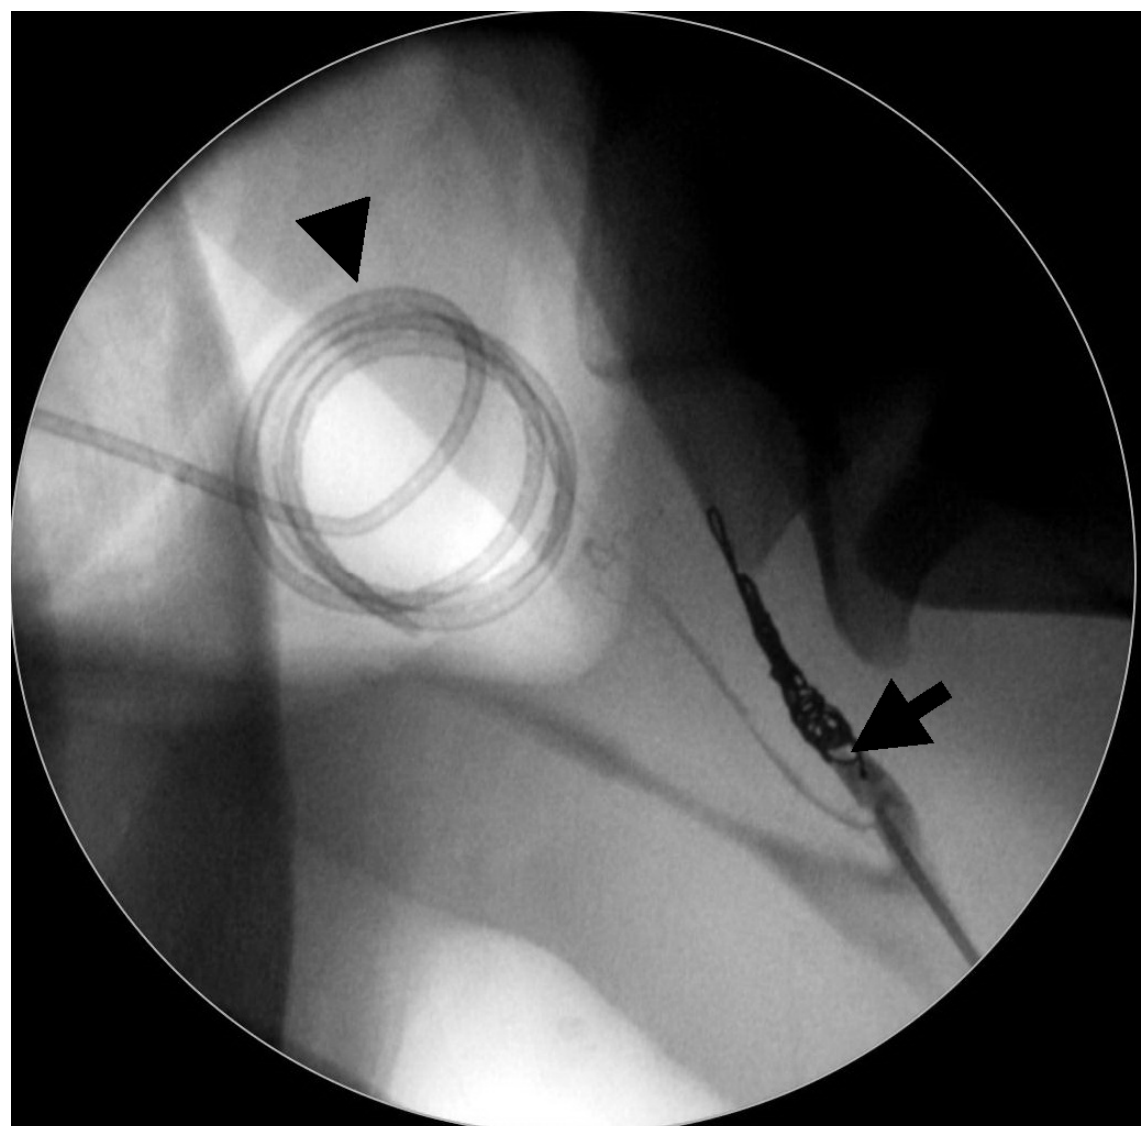
Figure 3. Fluoroscopic image obtained during general anesthesia of Horse 1. A TACE (transarterial coil embolization) procedure of the left ICA (internal carotid artery) (arrow) was performed simultaneously with a TOT (topical oxygen therapy) session. Note the spiraled catheter for oxygen administration sitting into the left GP (guttural pouch) (arrowhead).